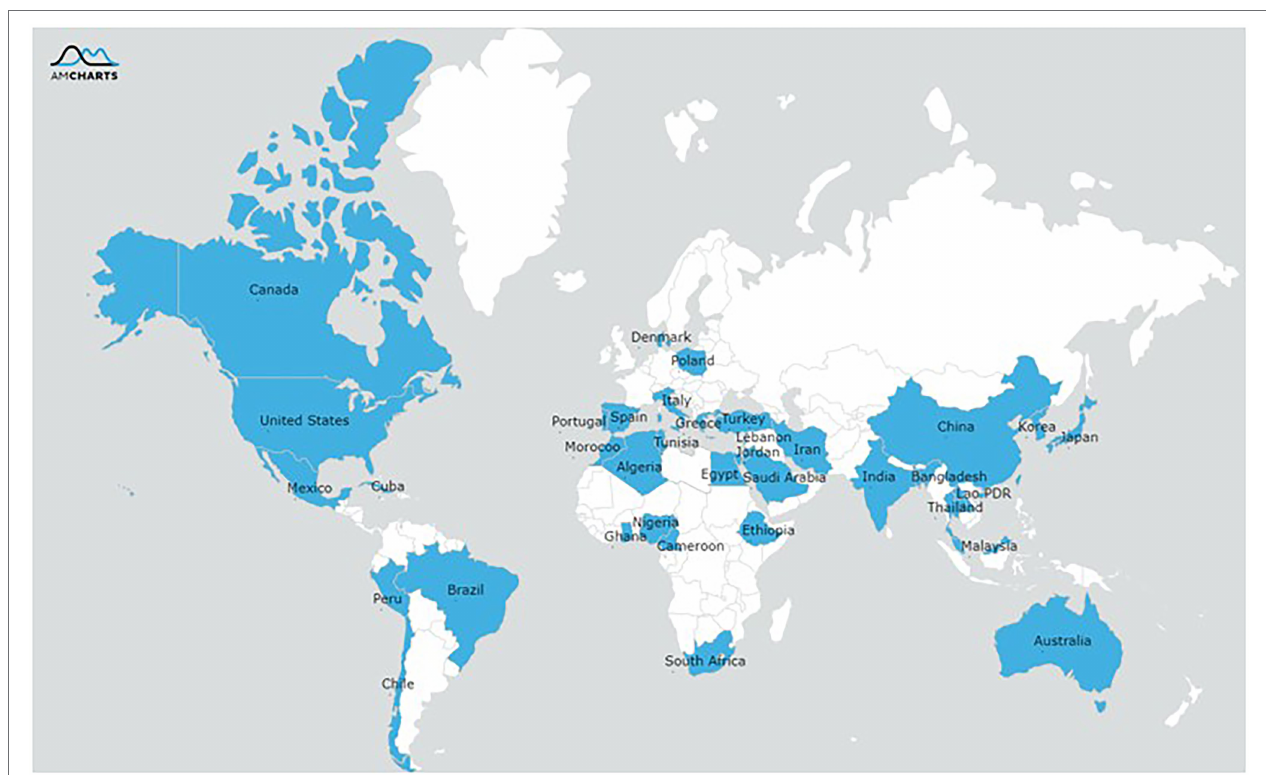
FIGURE 2 | Geographical distribution of reported resistance of the pathogens isolated from food or